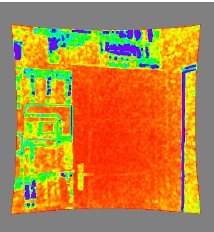
Figure 8: Manually selected point correspondences between the masked images.